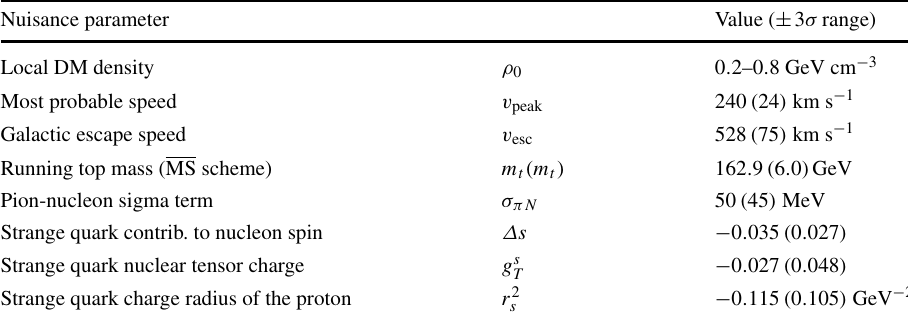
Table 4 A list of nuisance parameters that are varied simultaneously with the DM EFT model parameters in our scans (the hadronic parameters are given at μ = 2 GeV). All parameters are scanned over their 3 σ range using flat parametrisation. For more details on the respective nuisance likelihoods, see Sect.